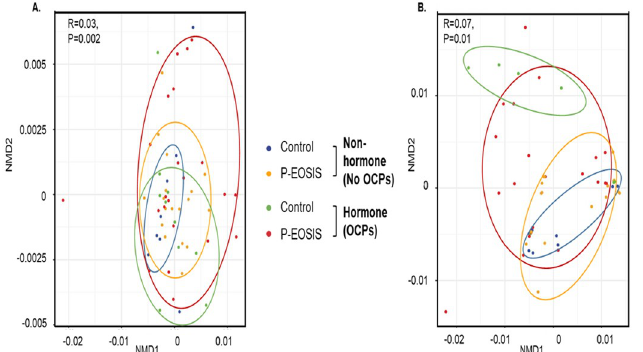
Fig 3. Non-metric dimensional scaling ordination of beta diversity analysis using UniFrac for GI/UG microbial composition. Patients with endometriosis (P-EOSIS) and control subjects (control) were either receiving or not receiving hormonal treatment (OCPs). A . Gastrointestinal tract. B . Urogenital tract. (No-OCPs samples: fecal: n = 9; vaginal swabs: n = 8; OCPs samples: fecal: n = 20; vaginal swabs: n = 20).